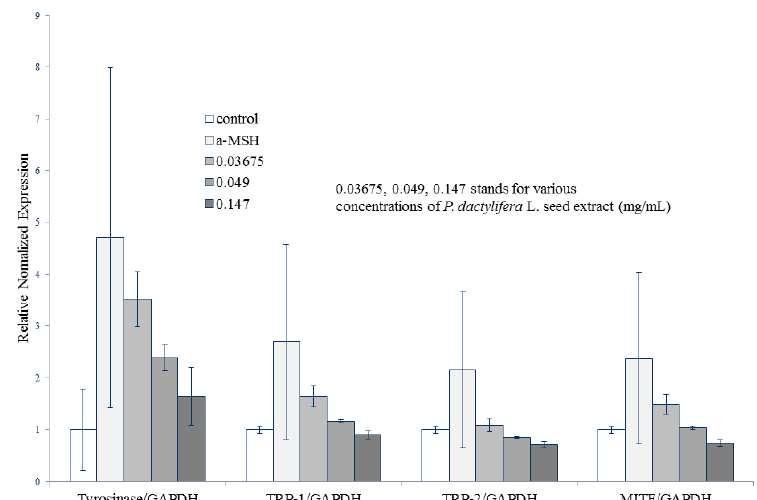
Figure 6. The effects of P. dactylifera L. seed extract on melanogenesis-related gene expression levels. Agarose gel electrophoresis of RT-PCR products of MITF, tyrosinase, TRP1, and TRP2. Total RNA from B16F10 cells treated with P. dactylifera L. seed extract (40 mg/mL) collected at the indicated time points. The mRNA levels were examined by real-time RT-PCR using glyceraldehyde 3-phosphate dehydrogenase (GAPDH) as an internal control.